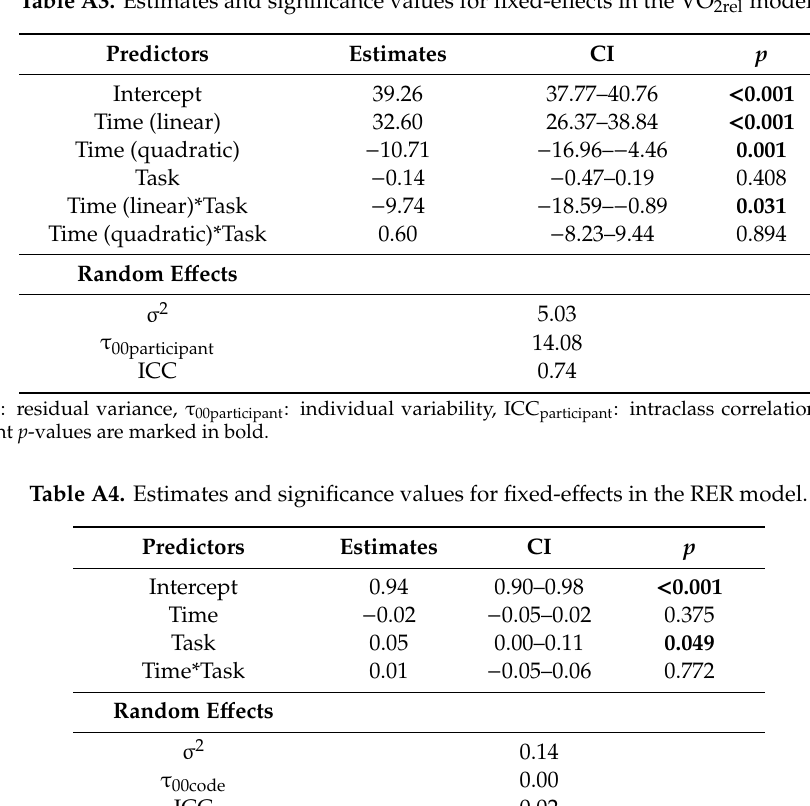
Table A3. Estimates and significance values for fixed-e ff ects in the VO 2rel model.